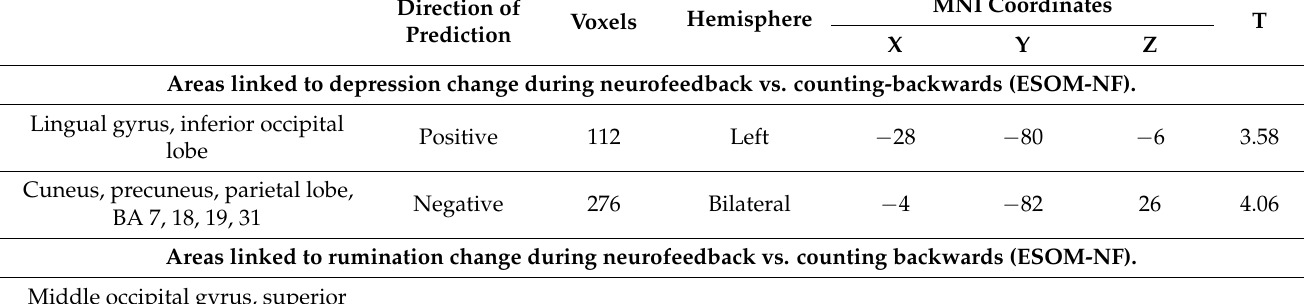
MNI Coordinates